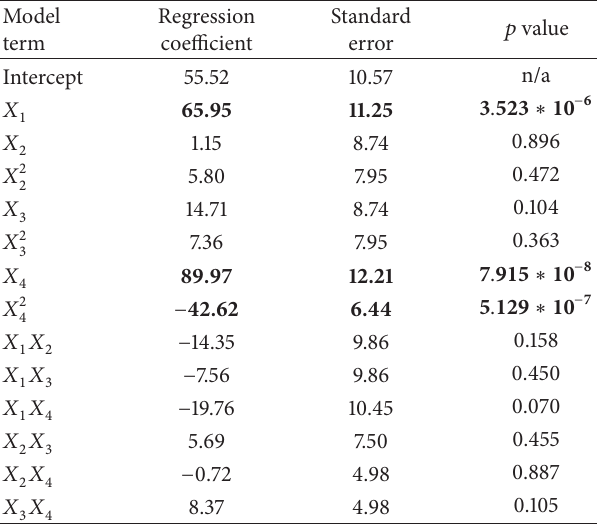
Table 3: Polynomial modelling of fluorescence intensity as a composite function of the four independent variables. Results (observed fluorescence intensities) of factorial experimental design as displayed in Table 2 were used for the modelling. Fluorescence intensity was recorded at excitation wavelength of 530 nm and emission wavelength of 607 nm. The regression coefficients and 𝑝 values of the linear main effects, the quadratic main effects, and the interaction effects of the four independent variables are reported. 𝑋 1 =codedvalueofcellconcentration, 𝑋 2 =codedvalueof ultrasonication power, 𝑋 3 = coded value of incubation temperature, and 𝑋 4 = coded value of Nile red dye